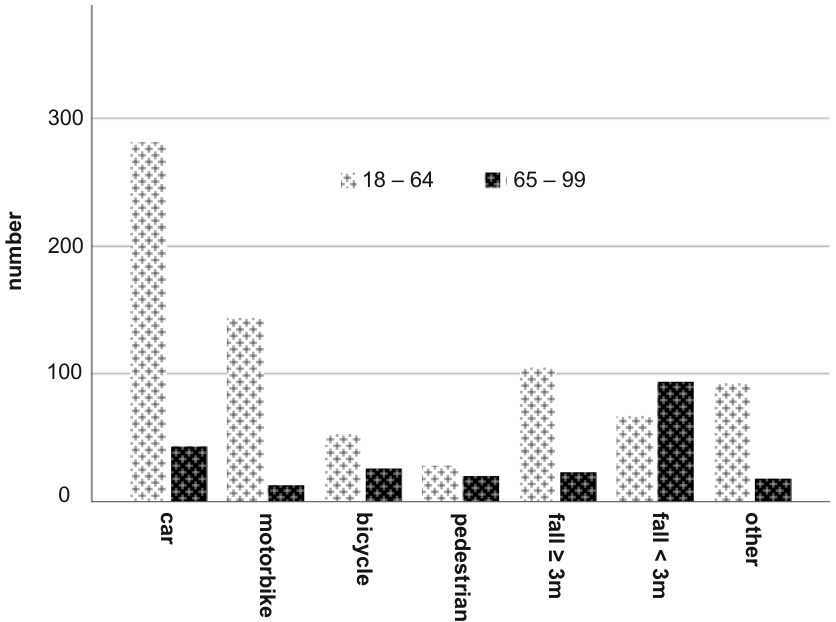
Figure 1. Trauma mechanism in both age groups.